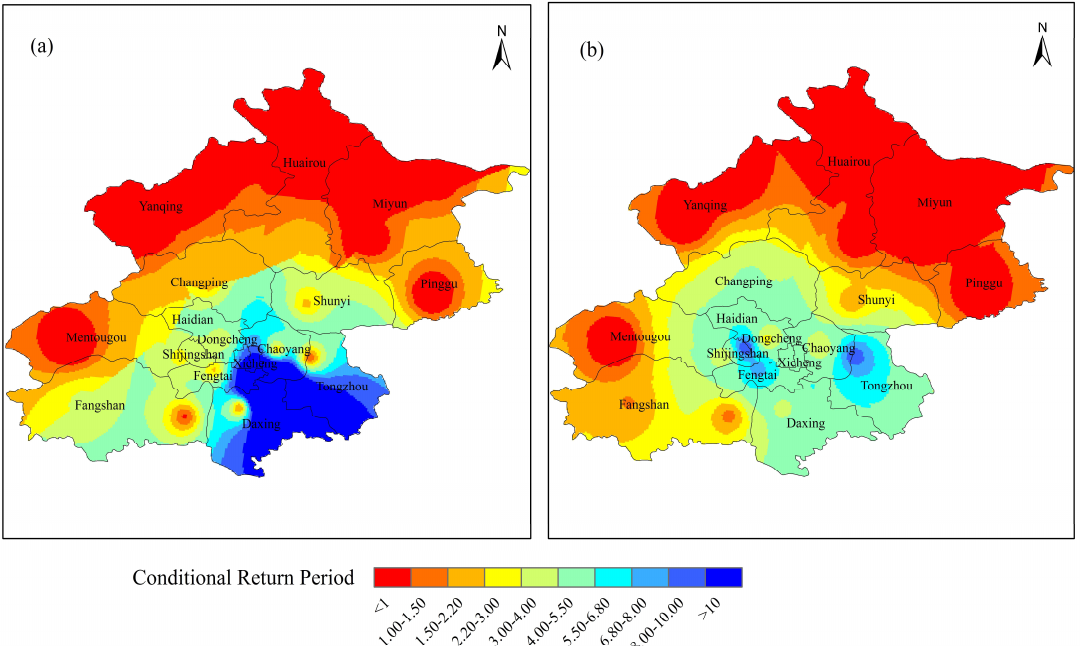
Figure 10. Spatial distributions of conditional return periods for extreme low temperature events of a given duration exceeding 2 days for study periods: ( a ) 1978–1998; ( b ) 1999–2015 (unit: year).